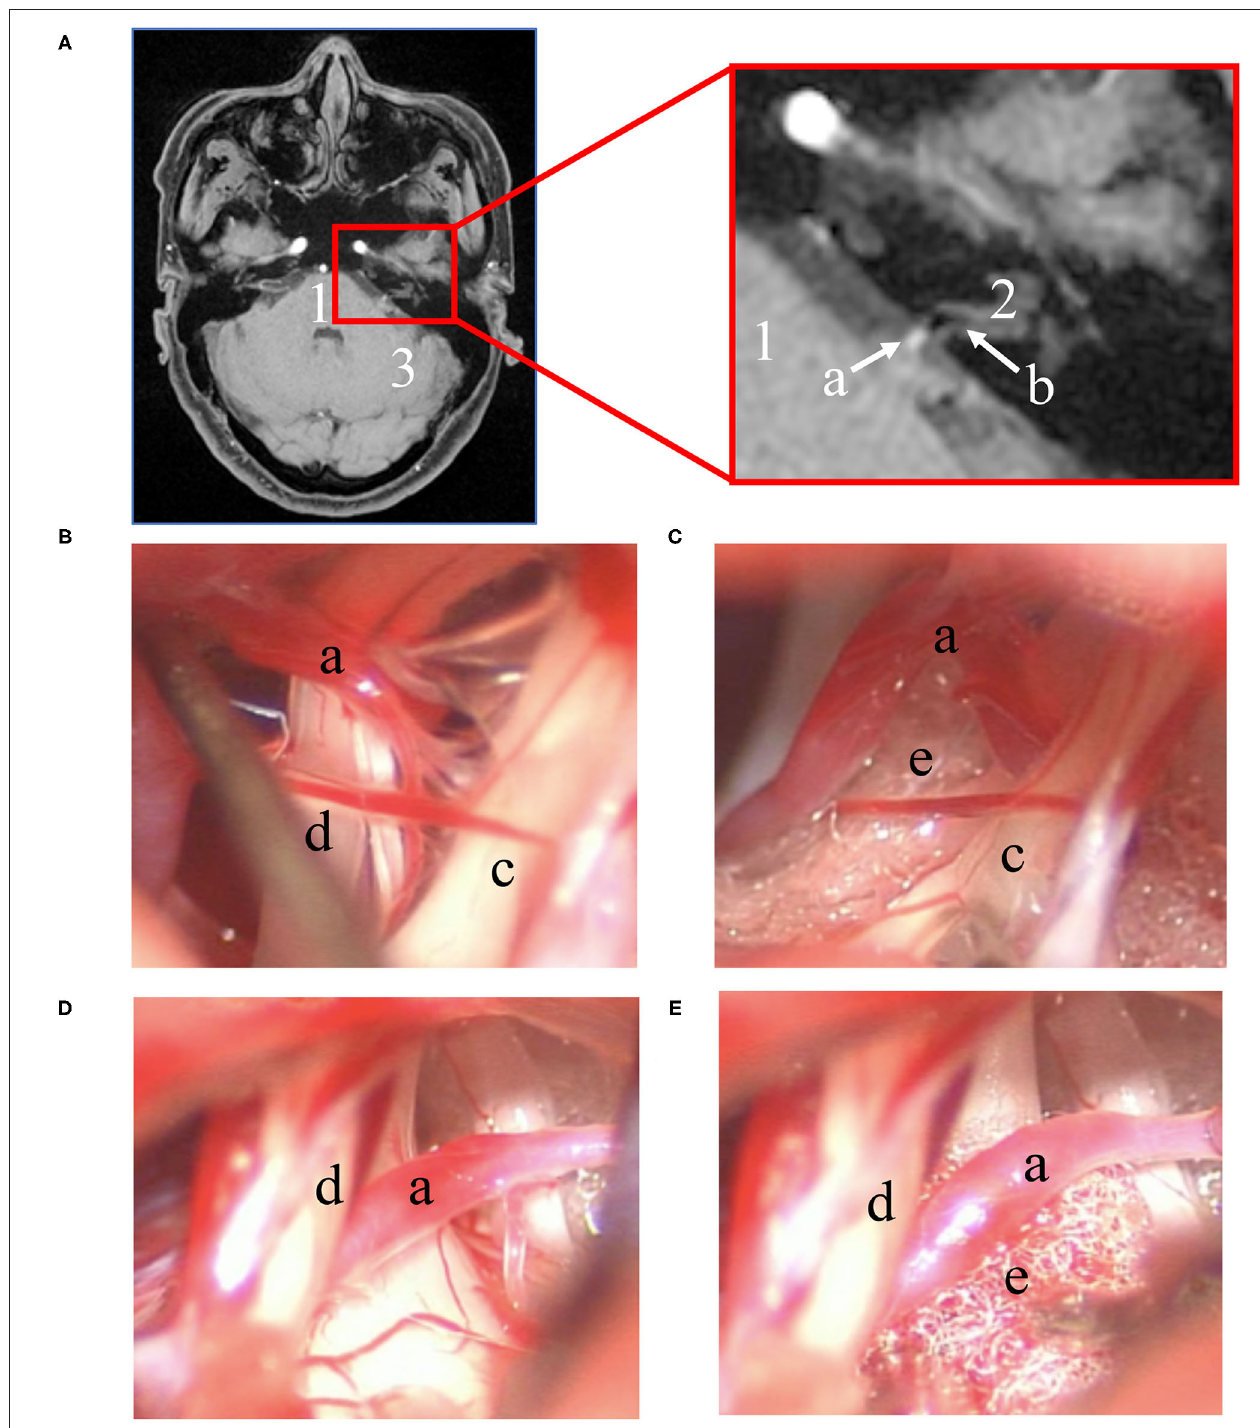
FIGURE 2 | Preoperative imaging and intraoperative findings. (A) Left: transverse section position of the REZ of MRTA images. Right: magnification of the red box in the left image. Intraoperative microscope photograph of the MVD procedure: (1) one of the surgical procedures involved using a nerve stripper to stretch the facial nerve for direct visualization of the NI (B) and placing a small piece of Teflon between the NI and AICA (C) ; (2) another procedure did not directly expose the NI (D) , and a small piece of Teflon was placed between the facial nerve and AICA (E) . (1: pons; 2: direction of the internal auditory canal; 3: left hemisphere of the cerebellum; a: AICA; b: the VII/VIII nerve complex; c: cranial nerve VII; d: cranial nerve VIII; e: Teflon).